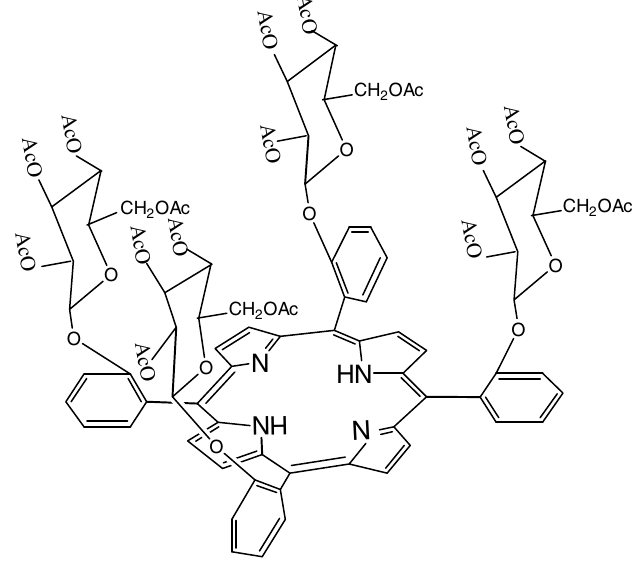
Figure 1. Structure of glycosylated